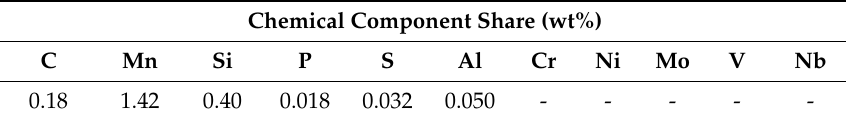
Table 1. Share of chemical elements (wt%) in S355J2G3